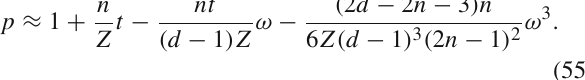
– For p = p c there is a cusp at T = T c , which coincides with the radius r + = r infl , thus, since at this point C = T d S / d T = − T (∂ 2 G /∂ T 2 ) → ∞ , the discontinuity on the second derivative of Gibbs function implies the presence of second order phase transition between small stable/large stable black holes.